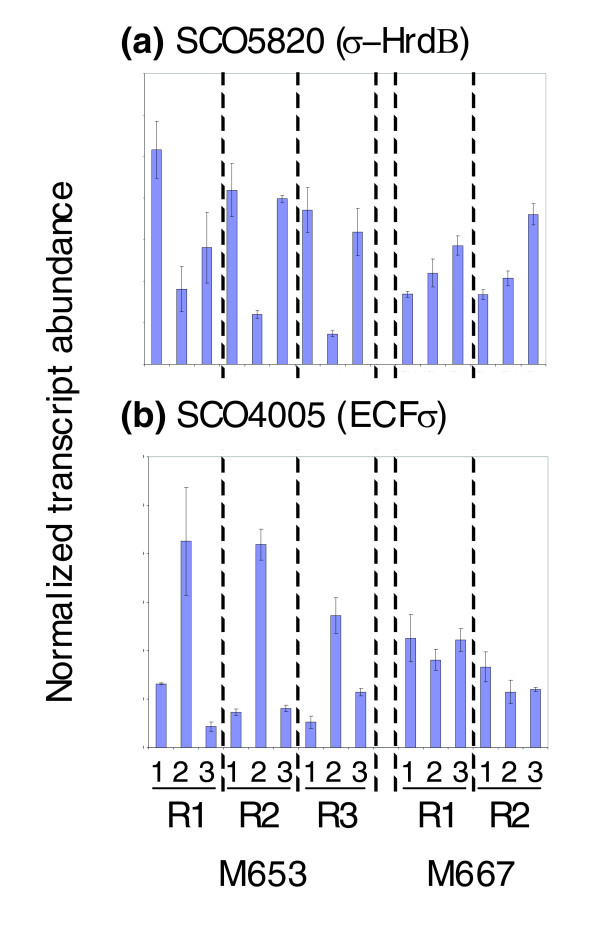
qRT-PCR shows transcription of the major vegetative sigma factor hrdB is repressed following induction of ppGpp synthesis, while the alternative ECF sigma factor encoded by SCO4005 is induced. In each biological replicate experiment, R1-R3, using strain M653 [ΔrelA tipAp::relA(1.46 kb)] or the control strain M667 [ΔrelA tipAp], lane 1 corresponds to the pre-induction sample (0 minutes) and lanes 2 and 3 correspond to the samples taken 60 minutes after induction or non-induction with thiostrepton, respectively. The average of three qRT-PCR determinations is shown, and standard deviations are marked with error bars.